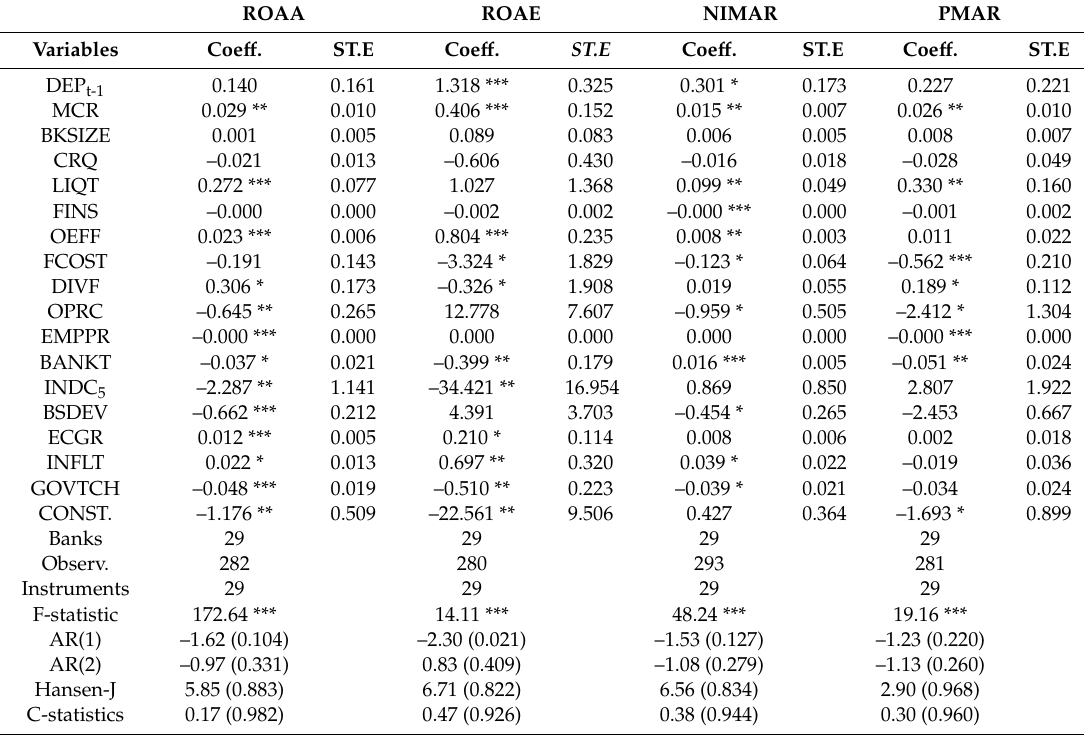
Table 9. Minimum capital requirement (MCR) and